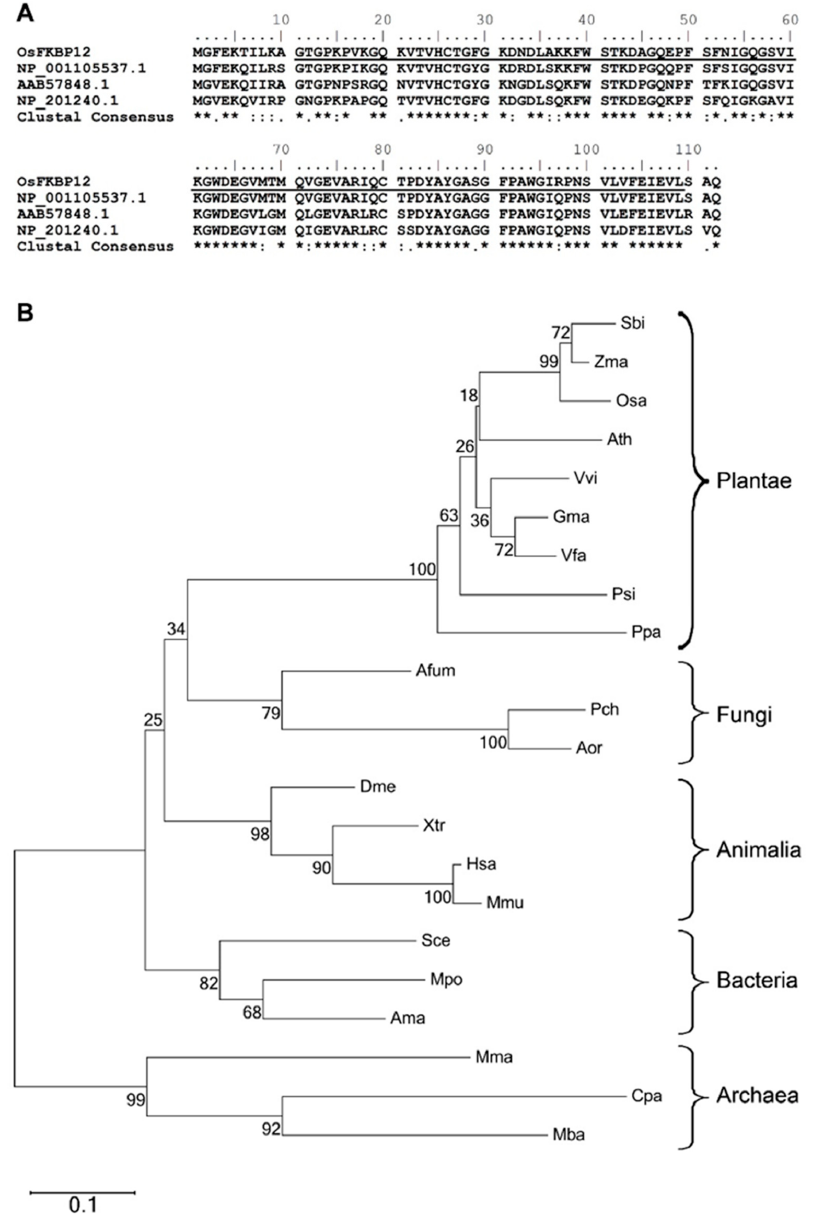
Figure 1. ( A ) Alignment of the OsFKBP12 protein sequence with homologs in Z. mays (NP_001105537), V. faba (AAB57848) and A. thaliana (NP_201240) illustrating the presence of the conserved FK506-